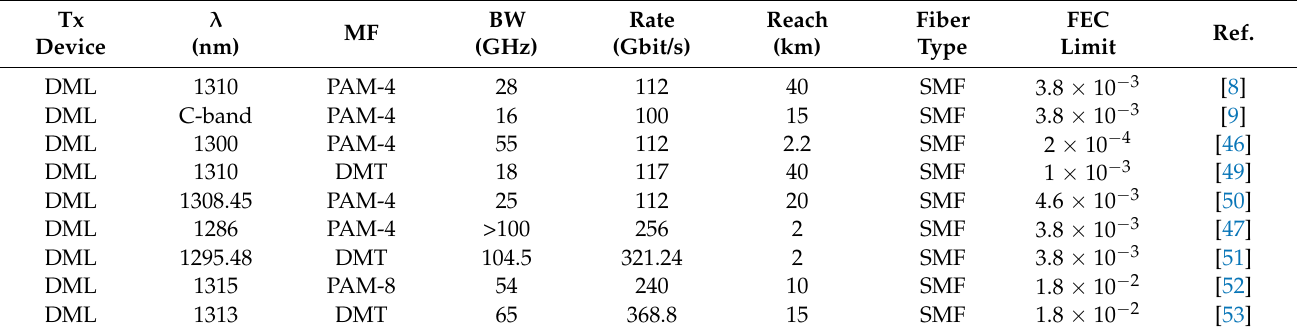
Figure 2. ( a ) S 21 amplitude responses for a bias range from 10–36.2 mA at 25 ◦ C; ( b ) S 21 amplitude and frequency responses at 36.2 mA gain bias at 25 ◦ C; FM: Frequency modulation; AM: Amplitude modulation; (From [46], © 2017 IEEE). Table 2. Incomplete summary of DML applied in beyond 100-Gbit/s per lane data transmission.